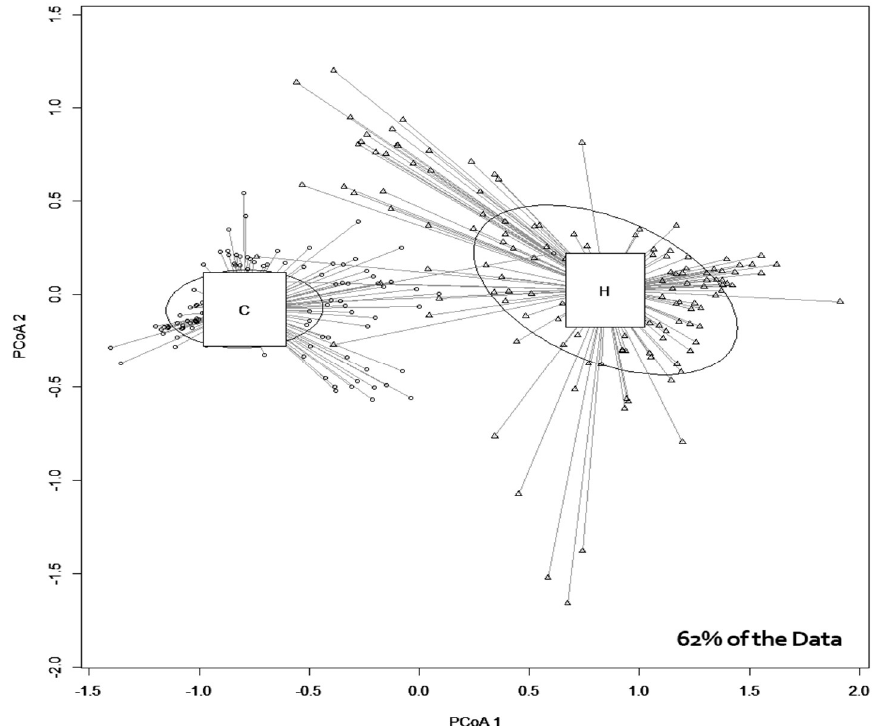
Figure 9. Principal coordinate analysis (PCoA, =multidimensional scaling, MDS); 62% of the data showed dissimilarities indicating an effect of water temperature on enzymatic activities. C: 14 o C H: 27 o C. △: represents the values of enzymatic activity in 27 o C. ○: represents the values of enzymatic acitivity in 14 o C.